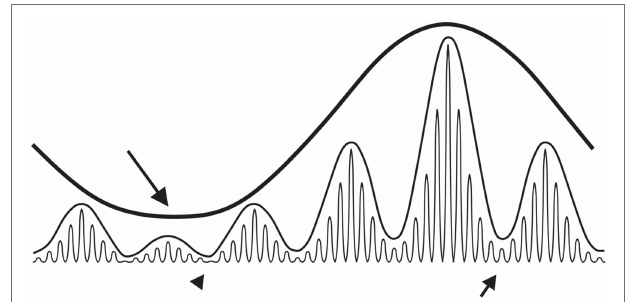
FIGURE 4 | Schematic representation of oscillation multiplexing. The long black arrow indicates the temporal window where the slowest rhythm exhibits maximal amplitude suppression of the medium-frequency oscillation (maximal gating). Conversely, the amplitude of the medium-frequency oscillation is at its highest during the slow rhythm acrophase. Similarly, the medium-frequency oscillation modulates the amplitude of the fastest oscillation. Complete gating of the fastest oscillation occurs where the nadir of both slow and medium- frequency rhythms coincides (black arrowhead). Note, that gating of the fastest oscillation by the medium-frequency rhythm is not that efficient near the acrophase of the slow rhythm (short